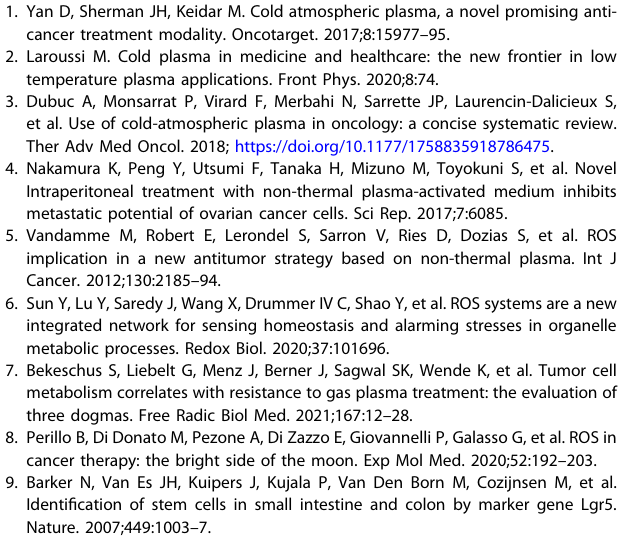
DATA AVAILABILITY The data sets generated and analyzed during the current study are available in